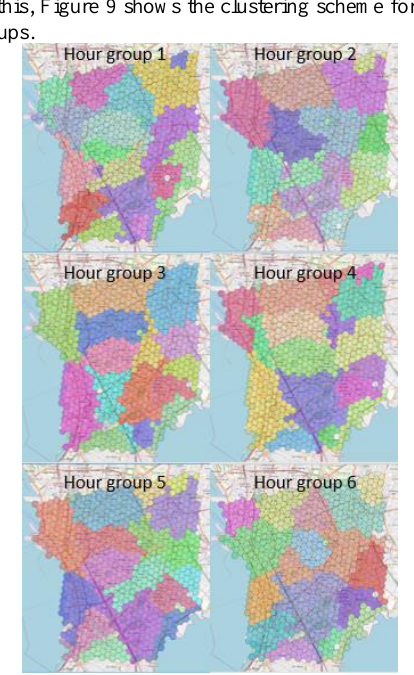
Figure 9. Clustering scheme for the six hour groups. Each color represents a cluster.